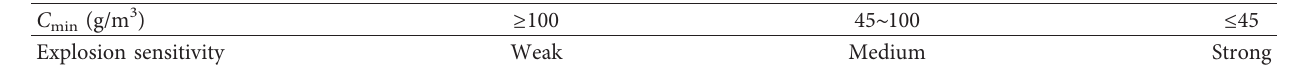
Table 9: Classification of dust explosion